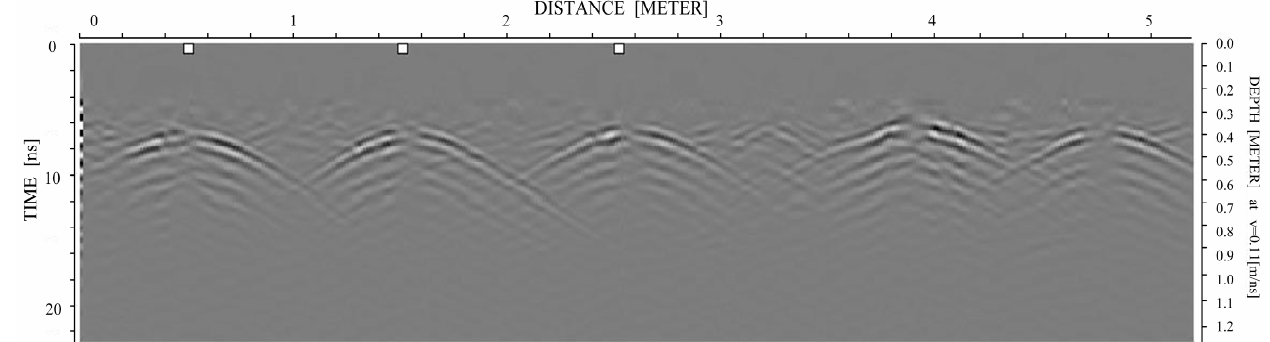
Figure 4. Ground penetrating radar image after removing the direct wave.